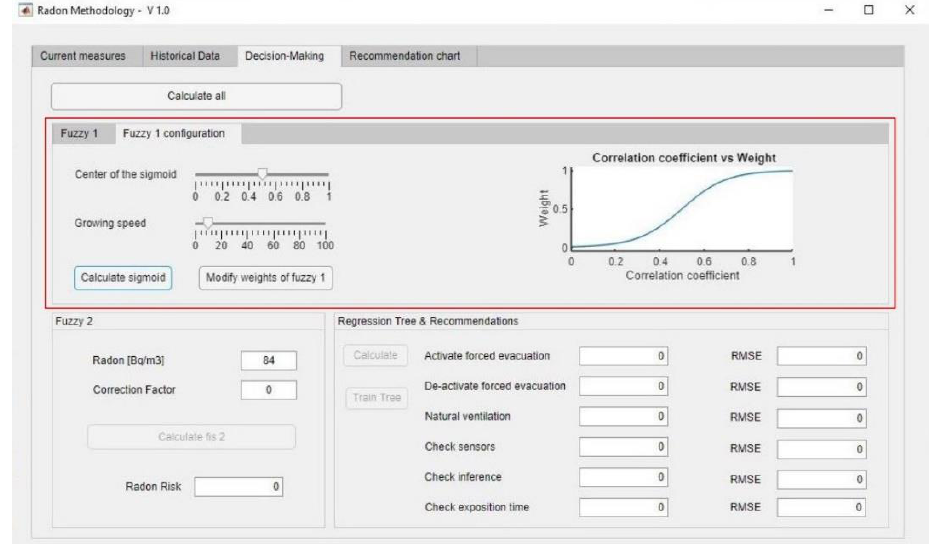
Figure 8. Dashboard for the definition of the sigmoidal function.